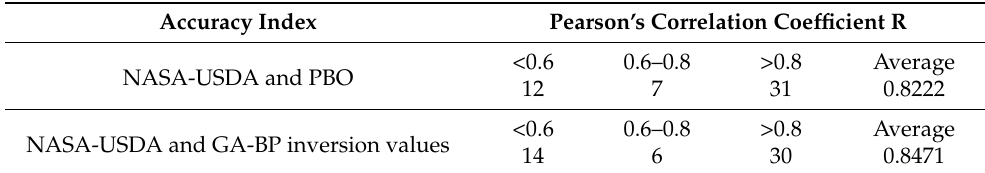
Table 5. Comparison of soil moisture values for NASA-USDA, PBO, and GA-BP